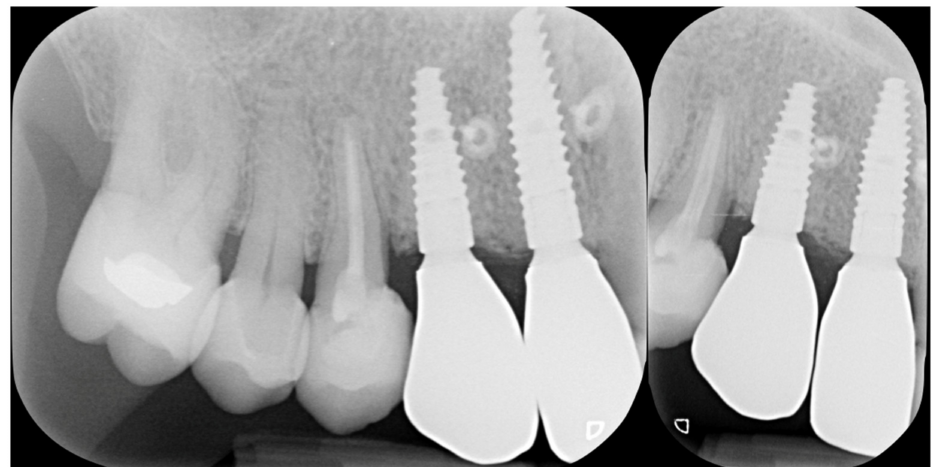
Figure 21. Rx of follow-up completion of restoration ( left ) and at 3 years after load ( right